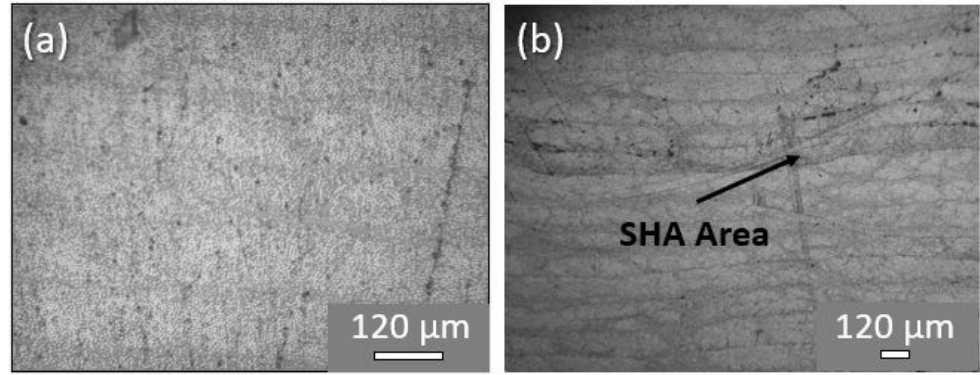
Figure 2. Representative optical microscopy images from cross-sections of ( a ) a reference and ( b ) a representative modified CFRP.